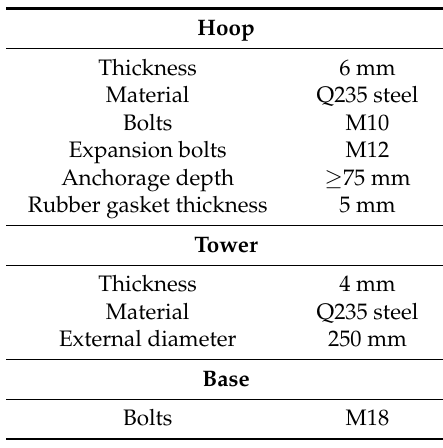
Table 4. Details of the supports of the wind